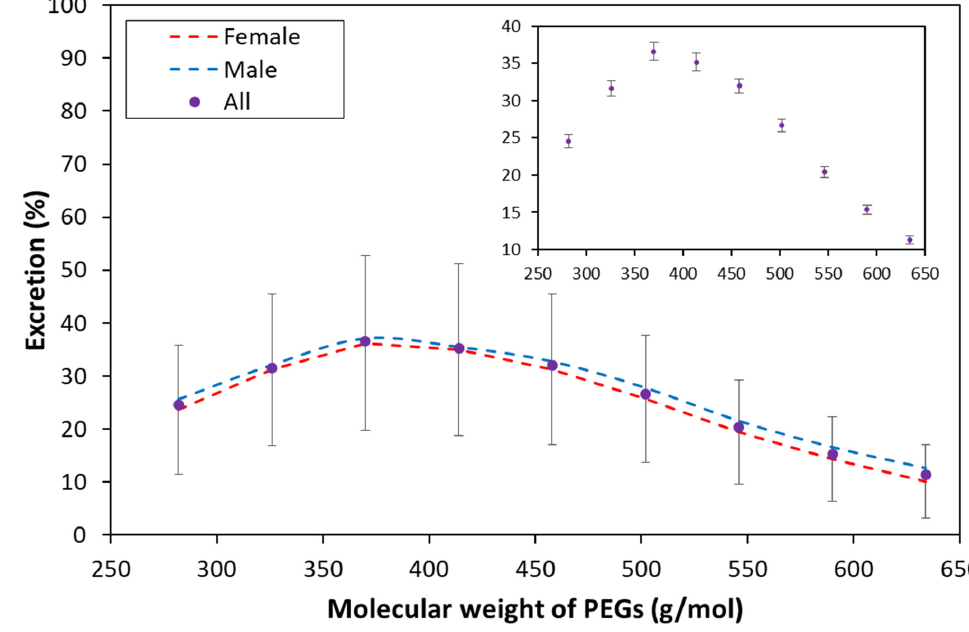
Figure 8. The average excretion ratios of the PEG 6–14 oligomers based on a sample of about 200 volunteers. The error bars represent the standard deviation of the subjects and the standard error of the mean in the main plot and in the inset, respectively. The red and blue regression curves belong to the average excretion ratios of the female and male volunteers, respectively. Table 2. Descriptive statistics of the excretion ratios (%) of the PEG 6-14